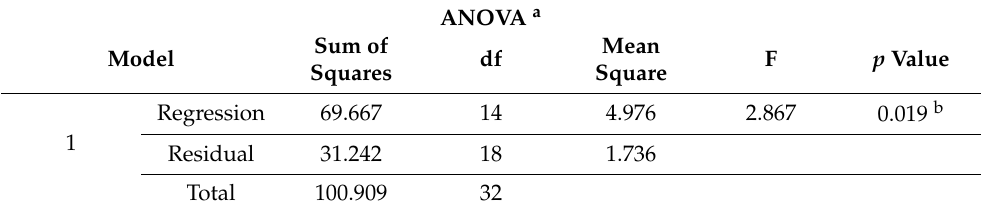
Table 11. Analysis of Variance—Importance of having a shared charging